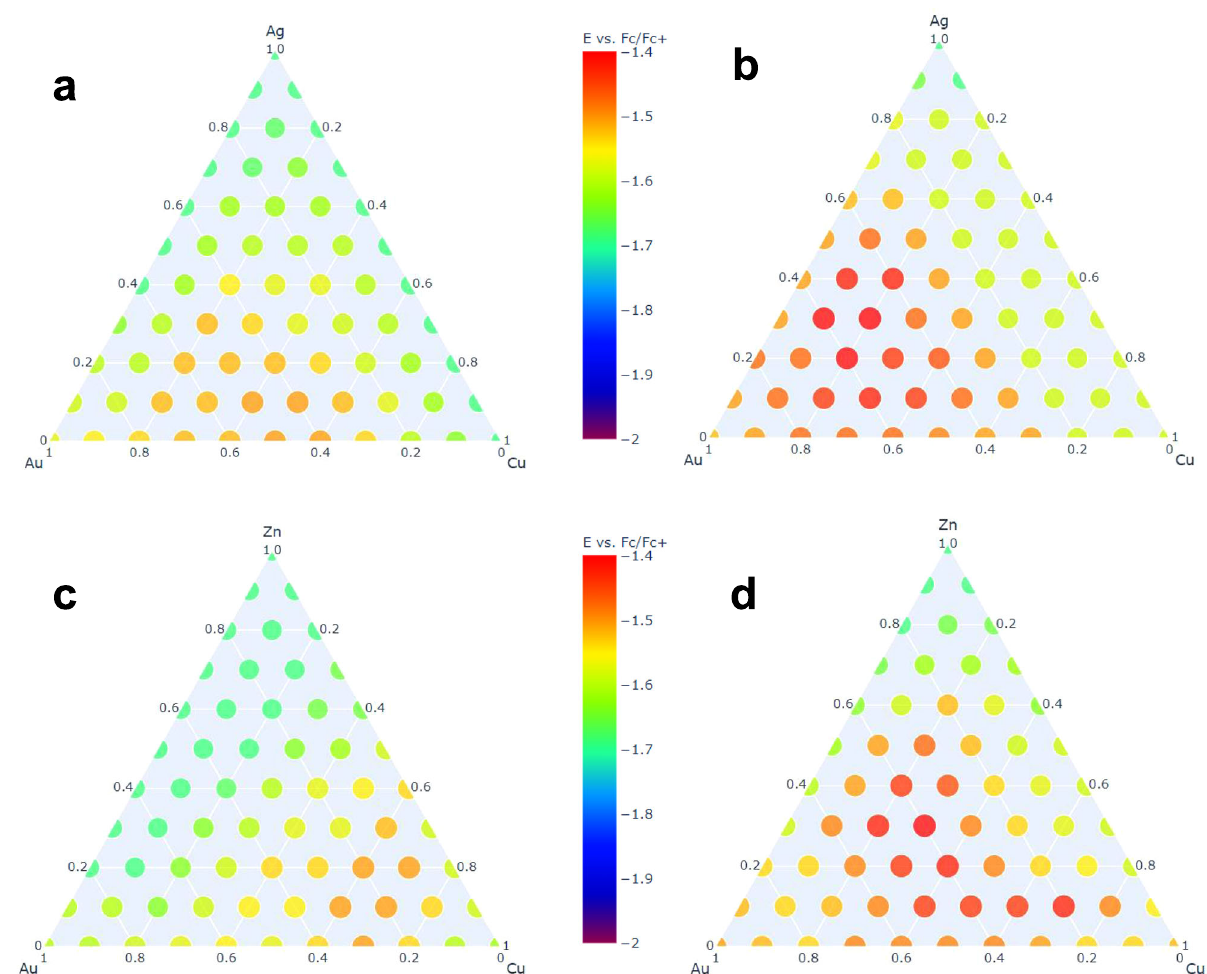
Fig. 3 Ternary catalyst screening results. a In total, 66 Au – Ag – Cu compositions screened under N 2 , and b under CO 2 . c Au – Zn – Cu compositions screened under N 2 , and d under CO 2. Screening experiments were performed with 1 M ionic liquid and 0.5 M DI water in